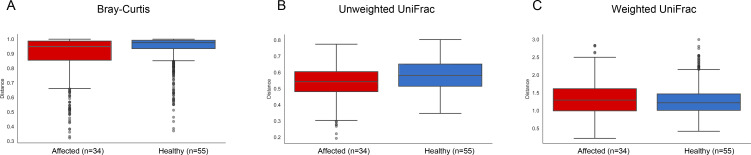
Beta diversity analysis between healthy and affected dogs.Bray Curtis (A), Unweighted (B) and Weighted UniFrac (C) distance matrices present an intra-group variation in healthy and affected dogs.